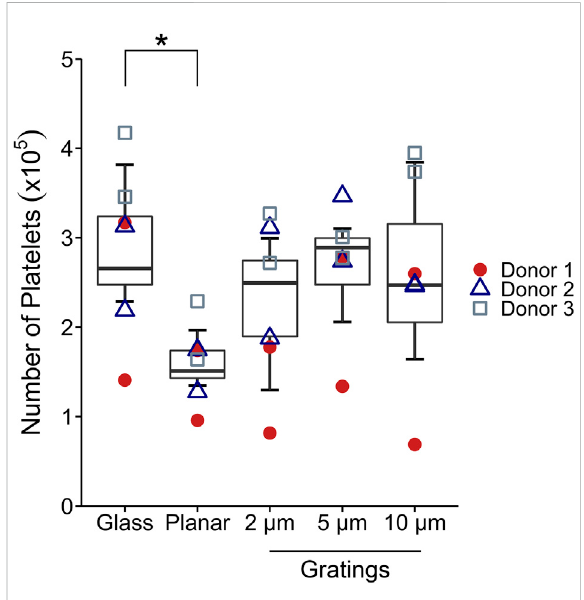
FIGURE 3 Invitro staticplateletadhesion.Plateletadhesionafter45 min of static incubation was quanti fi ed. Statistical analysis was performed using a two-way ANOVA with factors of the material type and platelet donor with Tukey ’ s HSD post-hoc test ( n = 6). A signi fi cant decrease in the number of platelets adhered was found for planar PVA compared to glass. No signi fi cant differences were observed between the micropatterned PVA compared to planar PVA. Signi fi cant differences were found between donor 1 and donor 3 ( p < 0.001). * indicates statistical signi fi cance ( p <